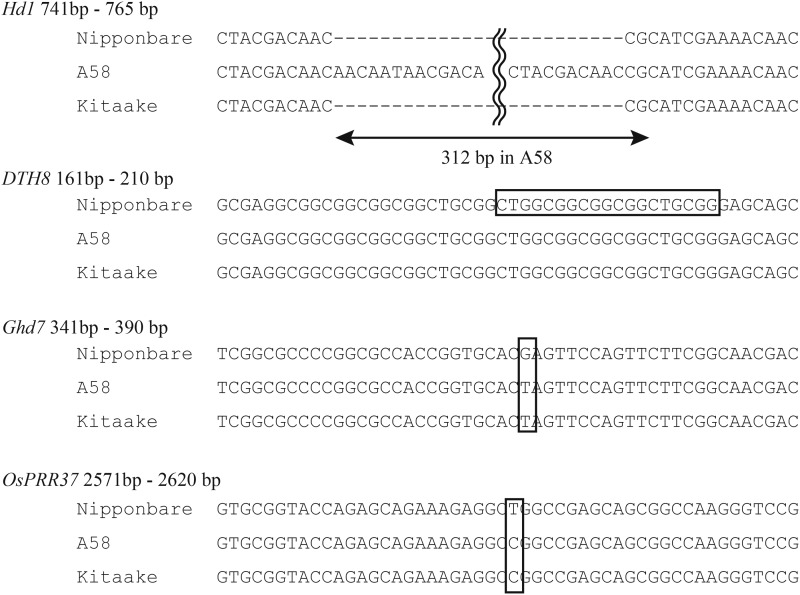
Comparisons of Nipponbare, A58, and Kitaake regarding the partial nucleotide sequences of four major loci affecting DTH in Hokkaido. The sequenced positions (based on Nipponbare) were selected using known polymorphisms among varieties grown in Hokkaido that were observed in previous studies (Ichitani et al. 1997; Fujino and Sekiguchi 2005a; Fujino and Sekiguchi 2005b; Nonoue et al. 2008; Fujino et al. 2013; Koo et al. 2013). Multiple differences in Hd1 were detected between A58 and Kitaake. Kitaake possesses a functional allele that is also present in Nipponbare. In DTH8, a 19-bp segment (indicated by a rectangle) was deleted in most of the other Hokkaido varieties, but not in Nipponbare, A58, and Kitaake, for which we could not detect any polymorphisms. For Ghd7 and OsPRR37, the SNPs observed in Nipponbare and the other two varieties are indicated by boxes.